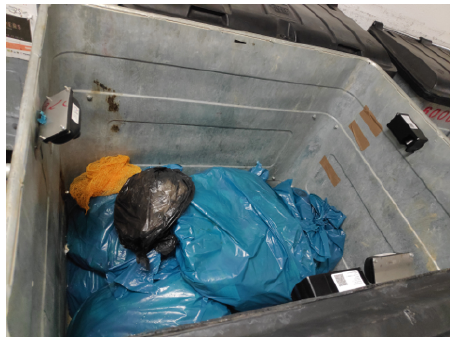
Figure 9. Testing of 4 sensors deployed into a container.